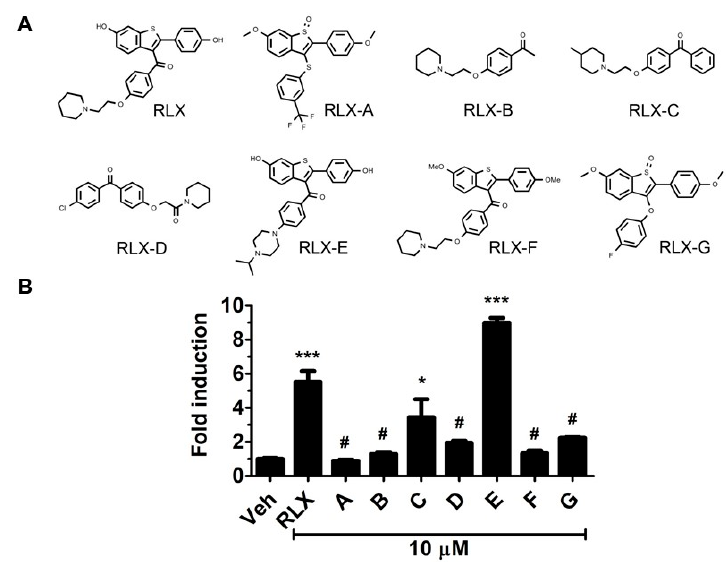
Figure 1. Structural analogs of raloxifene. ( A ) Four analogs share structural similarity to the raloxifene core (A, E, F, and G), and three analogs (B, C, and D) have similarity to the non-core aspects of raloxifene. ( B ) The ability to activate AhR transcriptional activity was measured by AhRE-luciferase reporter activity in Hepa1 cells treated for 15 h with 0.1% DMSO (vehicle) or the indicated compounds. Reporter gene activity is normalized to the vehicle control and is presented as fold-change. Data are presented as the mean ± SEM ( n = 3–6), and were analyzed by one-way ANOVA followed by Dunnett test. *, p < 0.05; ***, p < 0.001; #, not significant.